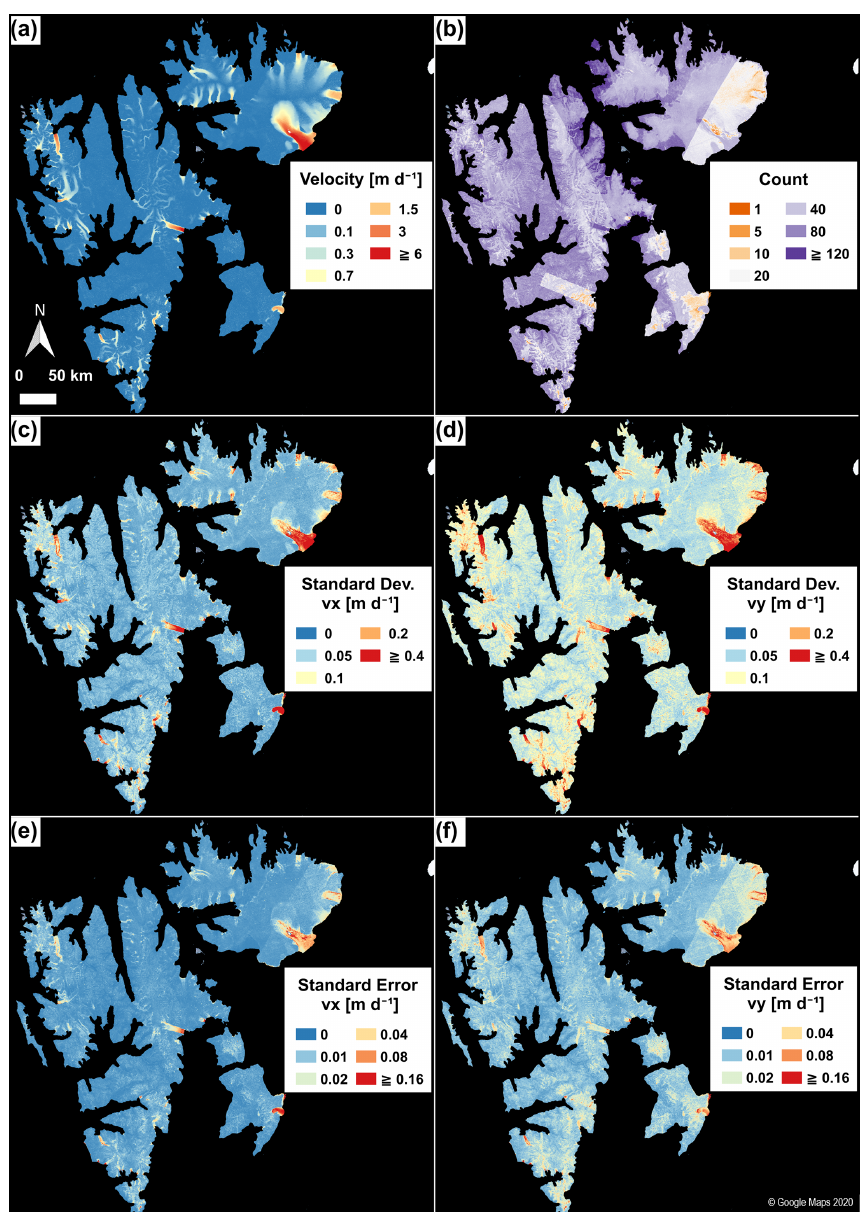
Figure 9. Sentinel-1 surface velocity mosaic generated from 557 scene-pair velocity fields with a 2019 time stamp. (a) Velocity magnitude, (b) measurement count per pixel, (c) weighted standard deviation of the x velocity component, (d) weighted standard deviation of the y velocity component, (e) weighted standard error of the x velocity component, and (f) weighted standard error of the y velocity component. Background: © Google Maps 2020, overlain by an OpenStreetMap-based ocean polygon data set in black (https://osmdata.openstreetmap.de/ data/water-polygons.html, © OpenStreetMap contributors 2019. Distributed under the Open Data Commons Open Database License (ODbL)